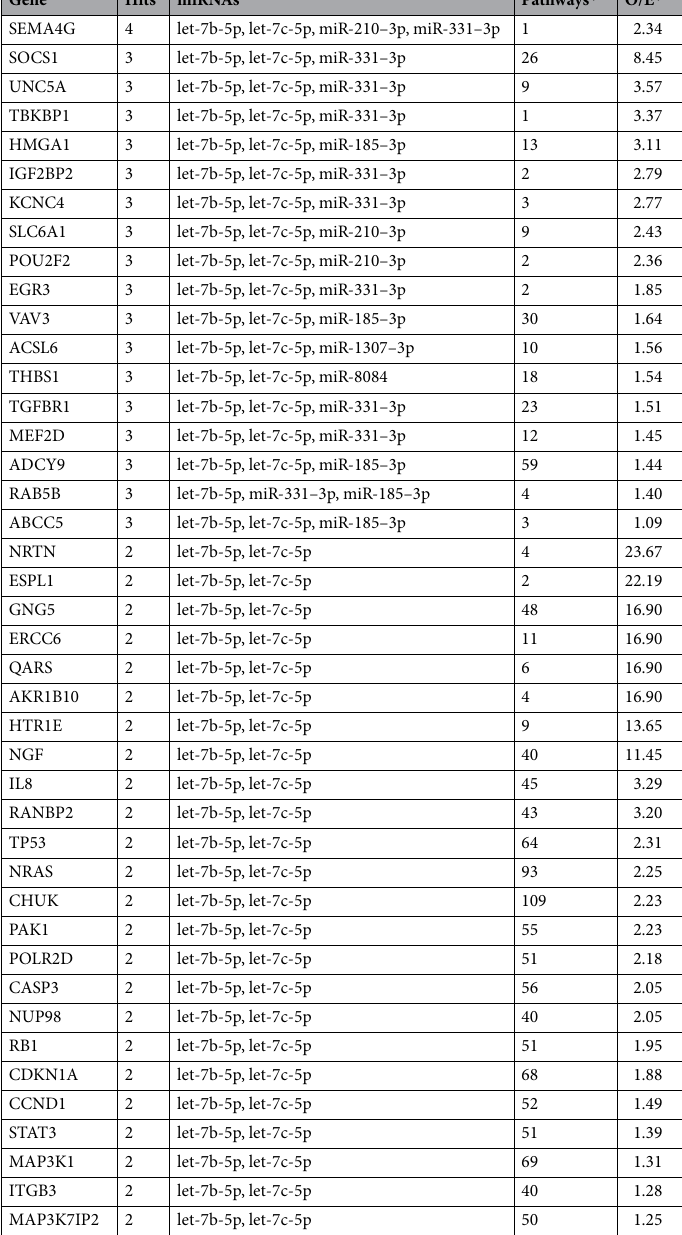
Table 3. Top target genes for the seven differentially expressed miRNAs in the Death/CLD group of CDH children. * Based only on miRSystem report for let-7b/c-5p, and miR-210-3p, -331–3p. O/E: ratio observed/ expected. Selection: O/E >= 1.0, Hits > 1, Pathways >= 1; if Hits = 2, then Pathways >= 40 or O/E >